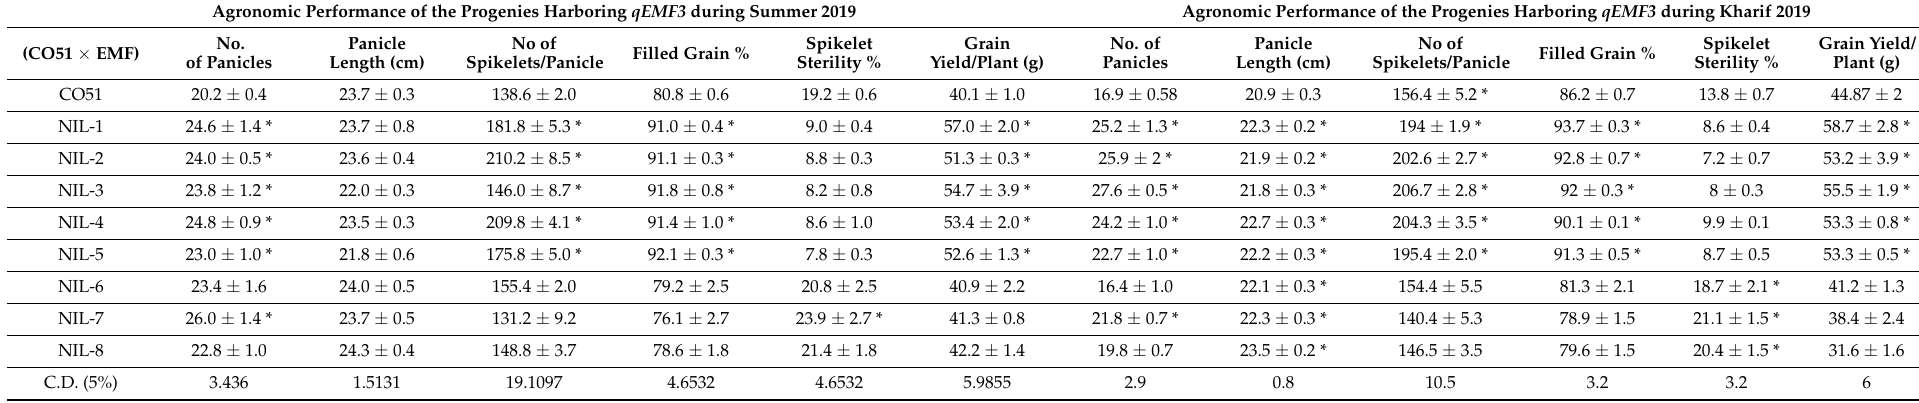
Table 3. Agronomic performance of the progenies of CO 51 harboring qEMF3